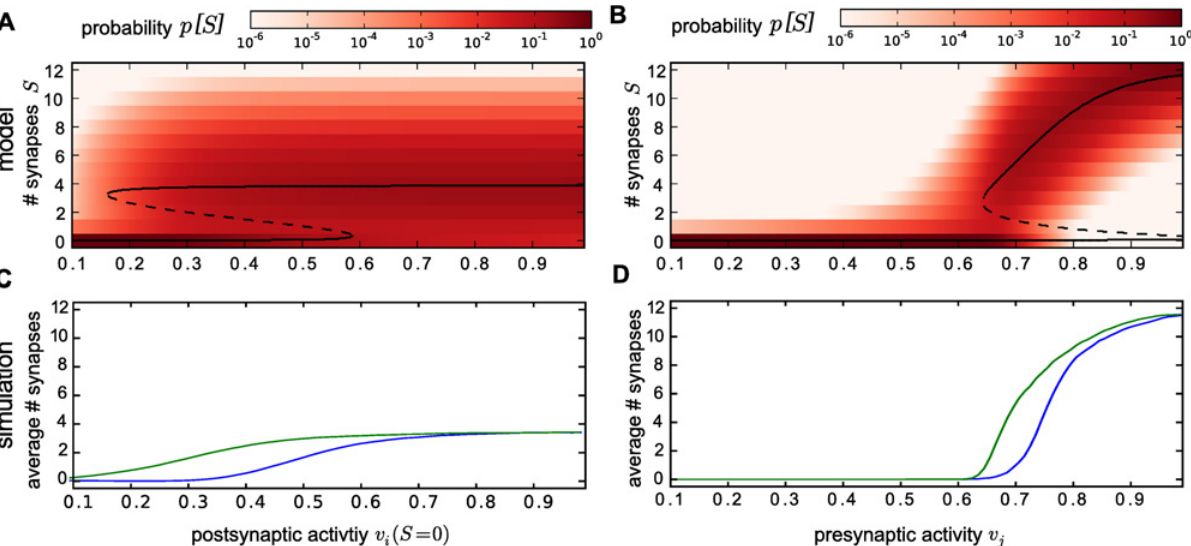
Figure 7. The BCM rule feedforward connection shows a hysteresis in pre- and postsynaptic stimulation. (A) The predicted probability distributions p [ S ] (in colour-code) for the system from Fig. 4A is strongly influenced by varying the postsynaptic stimulation. Black lines indicate the values of S (treated as continuous variable) for which synapse creation and deletion are equally probable. These points correspond to stable (continuous line) or unstable (dashed line) fixed points of the dynamical system following the net probability flow of our system and indicate the existence of local extrema in the long-term equilibrium probability distribution. Two bifurcations lead to an appearance and disappearance of a bistability, which indicates a possible hysteresis. (B) The same applies for varying the presynaptic activity, although the second bifurcation on the right hand side does not reveal for continuous S , but takes place in the discrete case as both sign changes happen between two consecutive states. (C) Simulation reveals the predicted hysteresis: postsynaptic stimulation was increased stepwise such that v i ( S = 0) increased by steps of 0.01 until it reached 1.0 and then decreased again. For each stimulation, the average number of synapses was calculated separately for the in- and decreasing direction and later averaged over all stimulation cycles (see Methods). The blue curve depicts the average number of synapses in the increasing and the green curve the decreasing direction. (D) Altering presynaptic activity in the same way also yields a hysteresis loop. (Parameters: BCM rule with synaptic scaling with μ = 0:2, θ = 0:08; υ tss = 0:1; κ = 9:0, structural plasticity P = 12; ln p build = − 16; a = 2.0; ρ = 0:125, in A, C : v j = 0.656, in B, D : v i ( S = 0) = 0.2975)